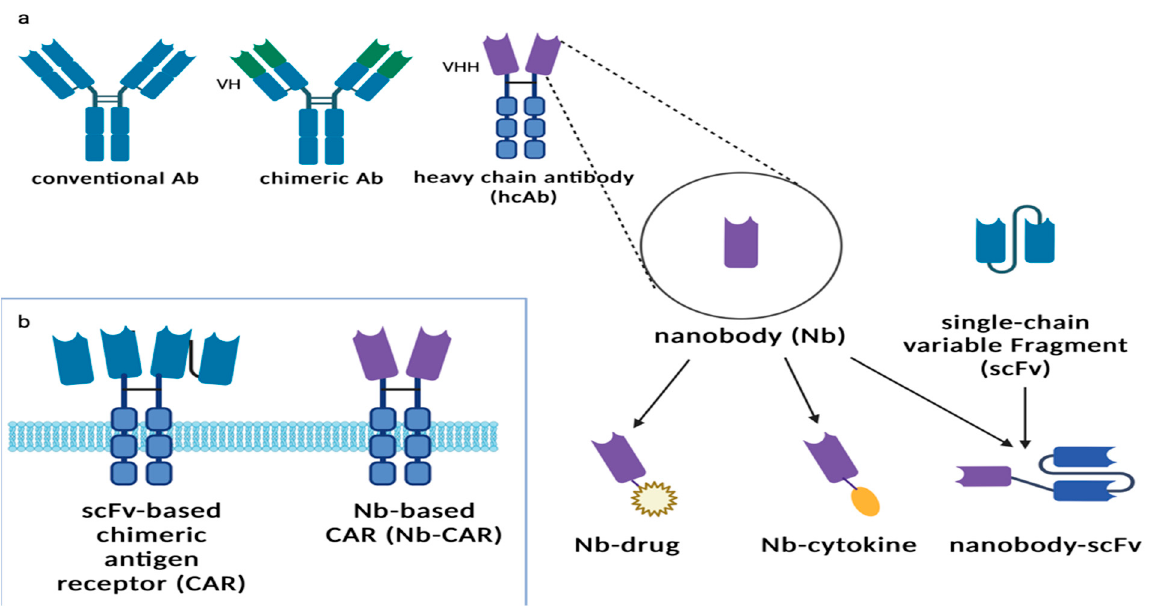
Figure 5. Comparison of conventional and nanobody ‐ based chimeric antigen receptors. ( a ) Schematic diagrams of a conventional antibody (Ab), camelid heavy chain antibody (hcAb), nanobody (Nb) and chimeric antibody, a single chain variable fragment (scFv), and nanobody ‐ scFv. ( b ) Schematic diagrams of conventional scFv ‐ based chimeric antigen receptor (CAR) and Nb ‐ based chimeric antigen receptor (Nb ‐ CAR) [129].